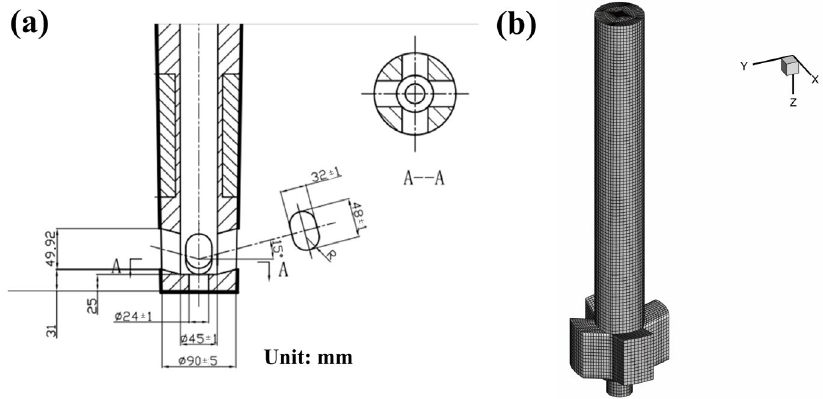
Figure 1. Schematic diagram of electromagnetic model: ( a ) aluminum probe load; ( b ) molten steel load.